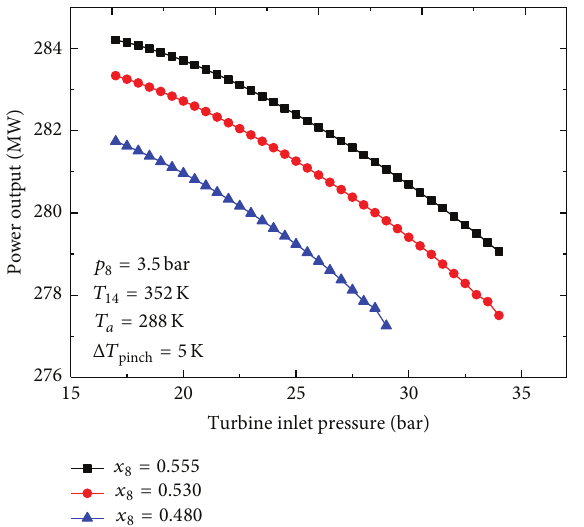
Figure 8: Variation of LEC of combined cycle with turbine inlet